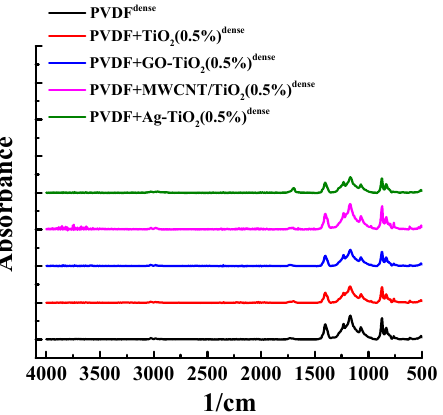
Figure 8. FTIR spectra for dense membranes based on PVDF and its composites with nanoparticles. The FTIR spectrum of the PVDF membrane showed characteristic peaks for this pol- ymer: at 2983 and 2928 cm − 1 peaks associated with asymmetric stretching of -CH 2 groups, peaks at 763, 834 cm − 1 associated with vibrations of -CH 2 groups and asymmetric stretch- ing of -CF 2 groups, the peak at 510 cm − 1 associated with the bending of -CF 2 groups, and at 480 cm − 1 the bending and vibration of -CF 2 groups [81]. The introduction of 0.5 wt% nanoparticles (TiO 2 , Ag-TiO 2 , GO-TiO 2 , and MWCNT/TiO 2 ) into the PVDF matrix did not lead to strong changes in the FTIR spectra, which may be due to low modifier concentra- tion [82].